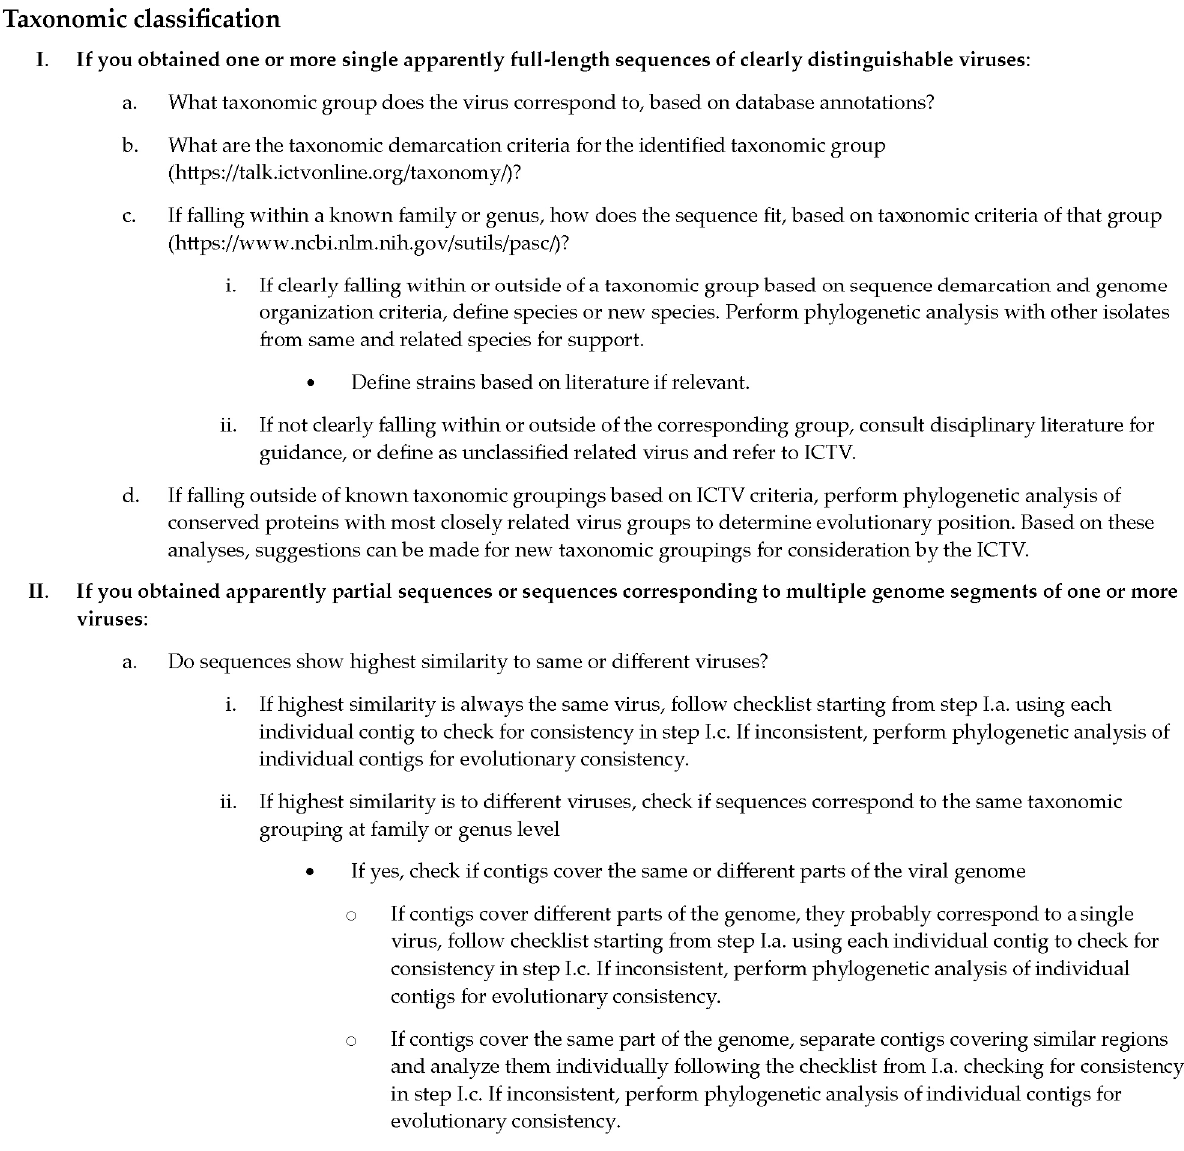
Figure 4. Checklist of the most important considerations during taxonomic classification of plant viruses detected by HTS.